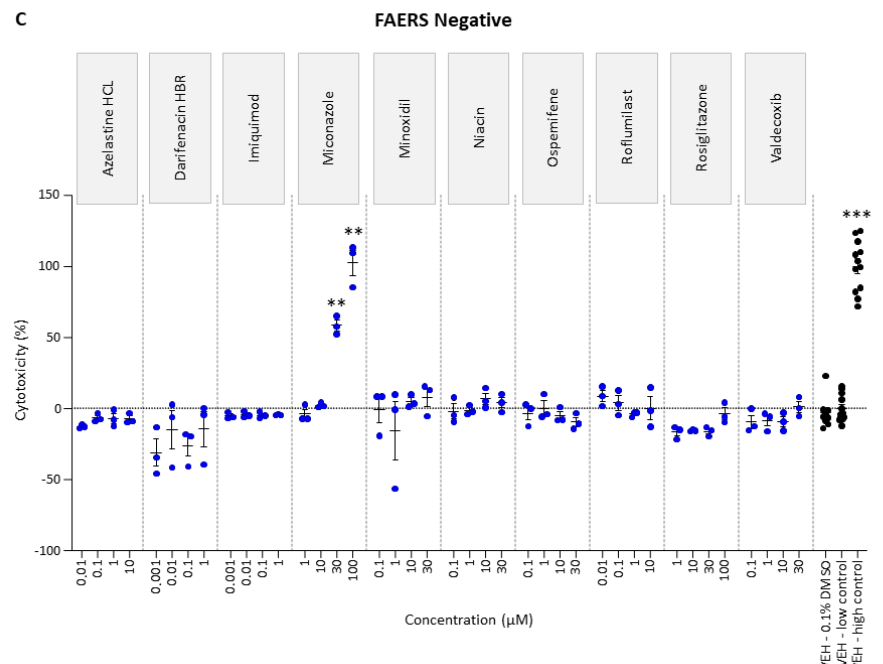
Figure 1. Cytotoxicity analysis of ( A ) tool, ( B ) FAERS-positive, and ( C ) FAERS-negative compounds in rat cortical neuronal cell cultures. Each compound was tested using four concentrations and pentylenetetrazol using six concentrations. Abbreviations : VEH, vehicle. Statistical significance : * p < 0.05, ** p < 0.01, *** p < 0.001 (vehicle 0.1% DMSO vs. compound-treated sample, Kruskal–Wallis followed by Mann–Whitney U-test). Data are presented as mean ± SEM. Table 1. Number of differentially expressed